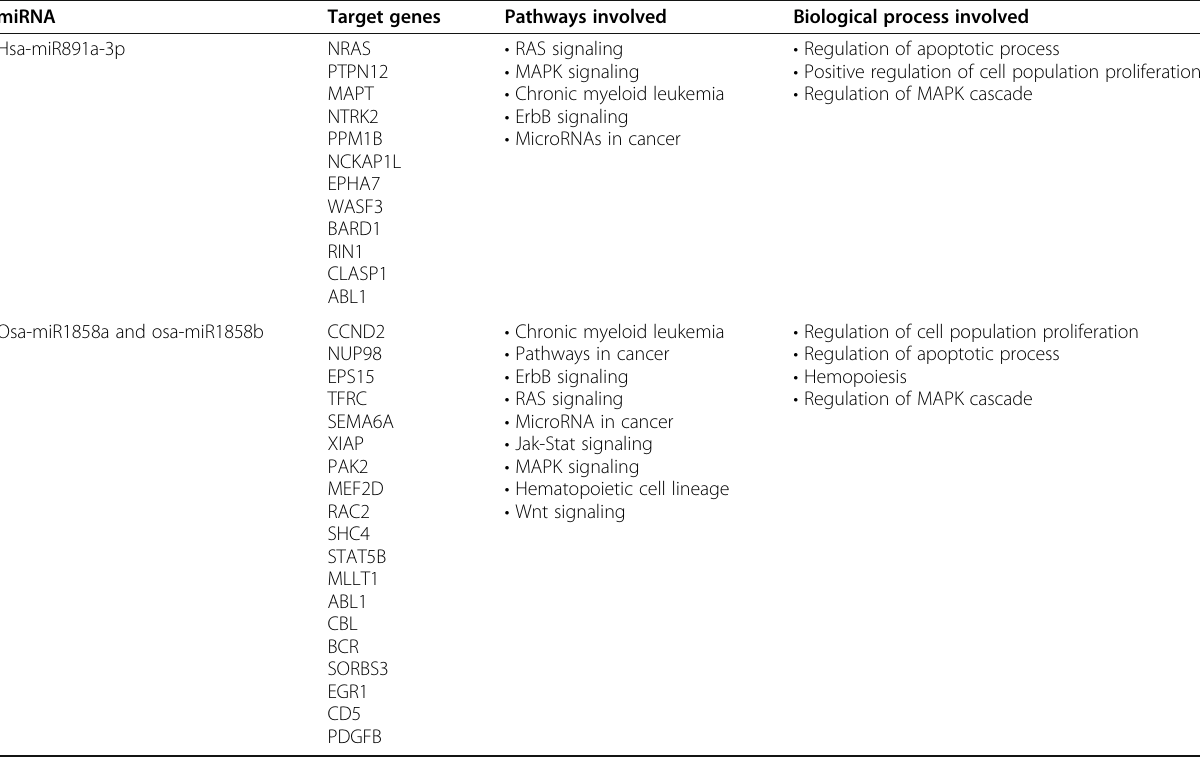
Table 2 The first neighbors of selected nodes (ABL1) of osa-miR1858a, osa-miR1858b, and hsa-miR891a-3p target genes, pathways, and Gene Ontology